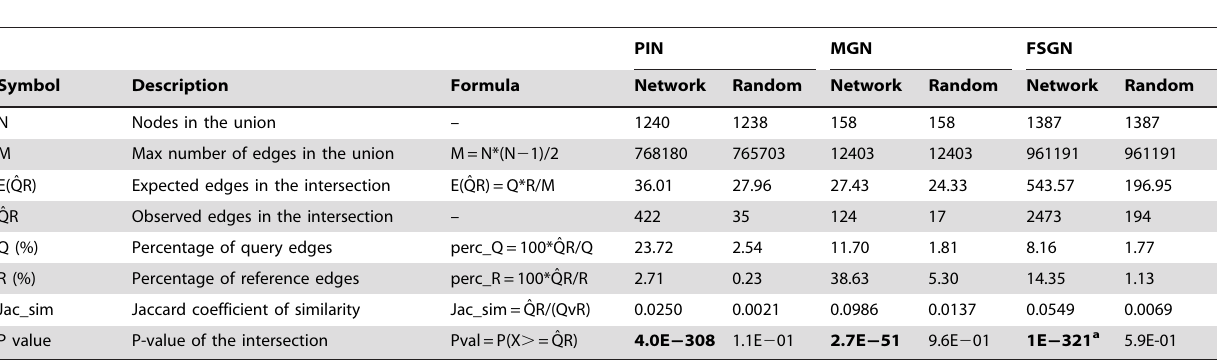
Table 7. Significance of the number of edges at the resulting intersection in the network analysis comparison.